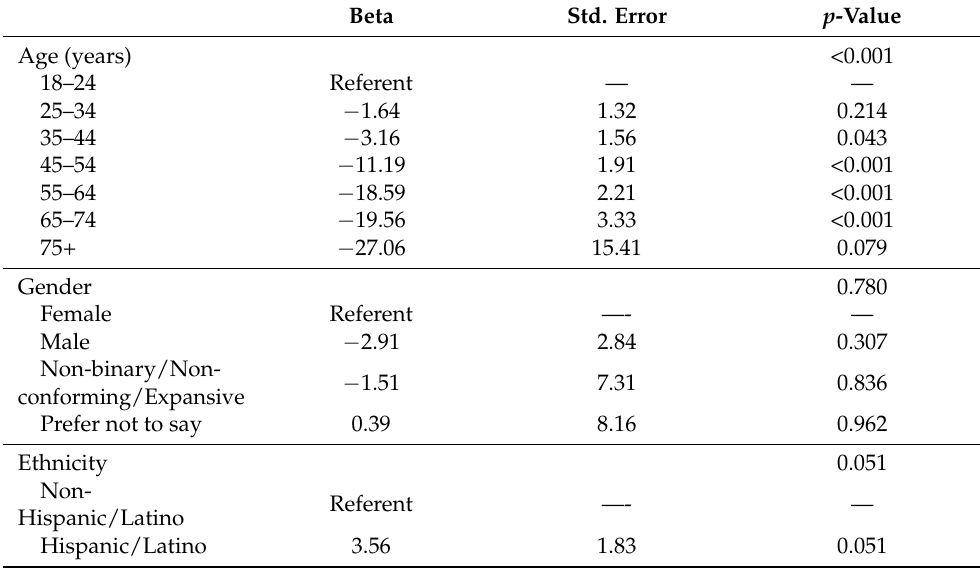
Table 3. Demographic Predictors of the Impostor Phenomenon in the Nutrition and Dietetics Profes- sion ( n = 1015) a